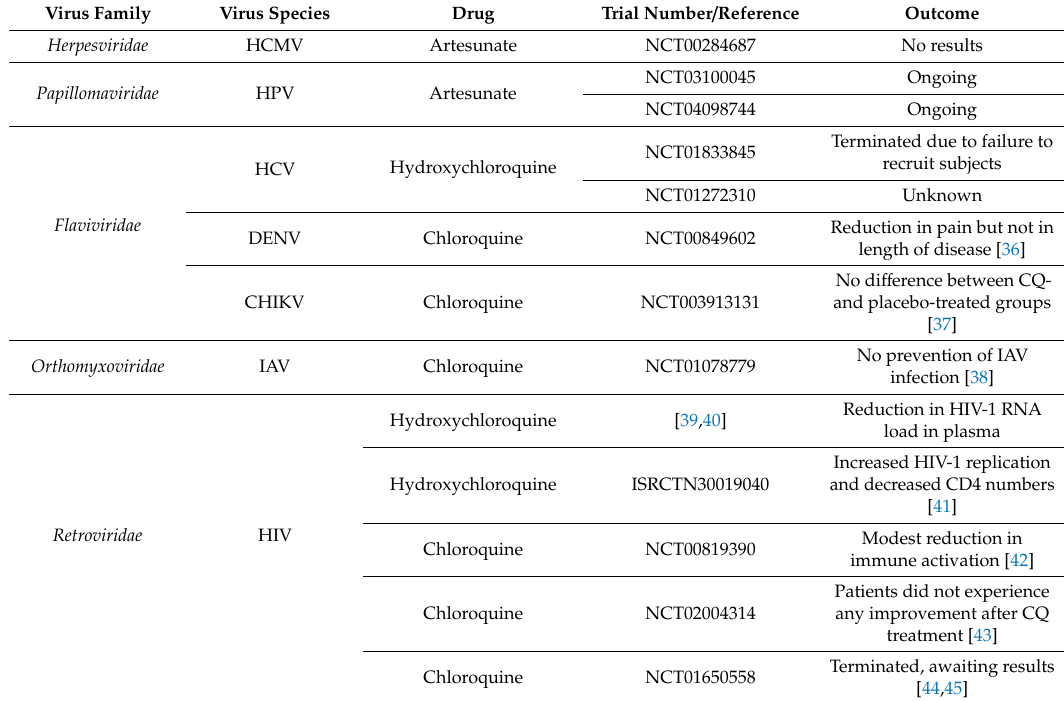
Table 1. Clinical trials for the evaluation of the activity of antimalarials on viral infections in